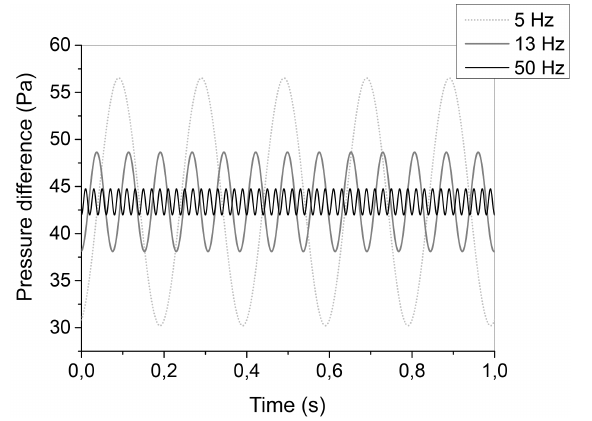
Figure 5. Amplitude (pressure difference) in dependence of the modulation frequency of the PAS system.